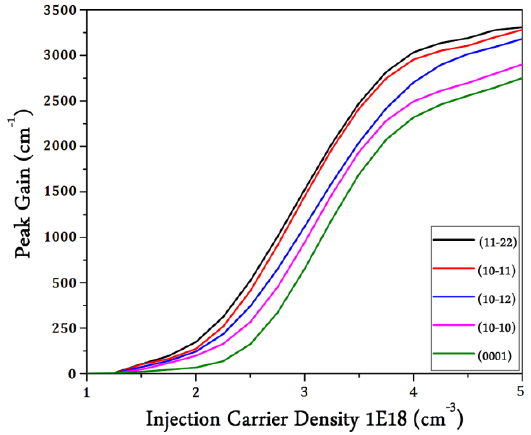
Figure 11. Optical gain in different crystal orientations depends on injection carrier density .